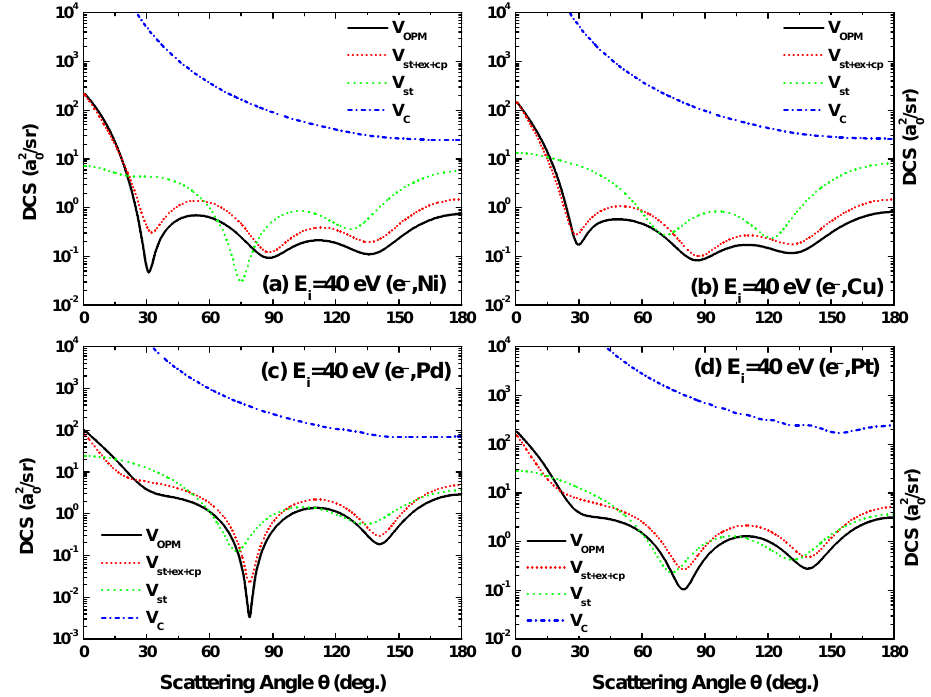
Figure 5. Angular dependence of the differential cross sections for electron scattering from ( a ) Ni 58 , ( b ) Cu 63 , ( c ) Pd 108 , and ( d ) Pt 196 at a fixed energy E i = 40 eV. Shown are the results from V st ( · · · · · · , green); V st + V ex + V cp ( − − − , red); and V OPM (——, black), along with the results for the Coulomb field, V c ( − · − · − ,